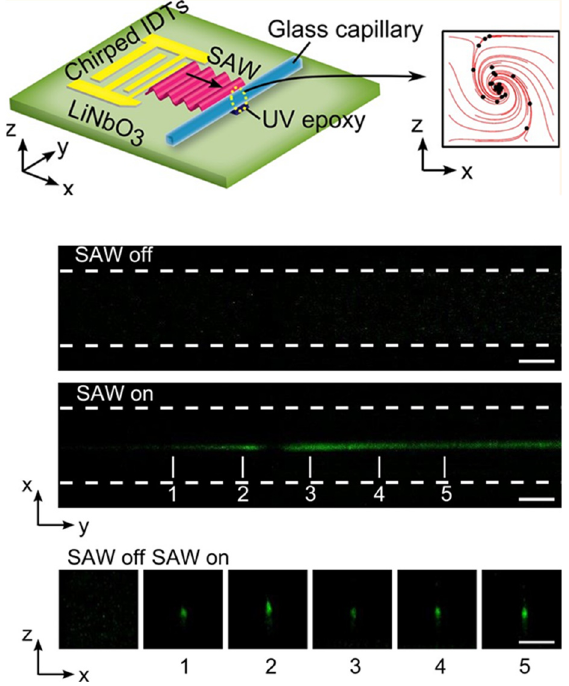
Figure 7. Acoustic focusing of nanoparticles in square cross-section glass capillaries by SAWs. Chirped interdigital transducers (IDTs) generate SAWs, which propagate into the capillary and generate acoustic streaming with a single vortex. 2D focusing of nanoparticles down to 80 nm was reported. Reprinted with permission from [58].